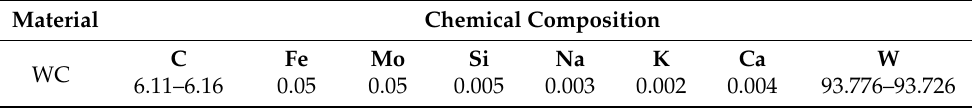
Table 3. Chemical compositional details of tungsten carbide particulate.